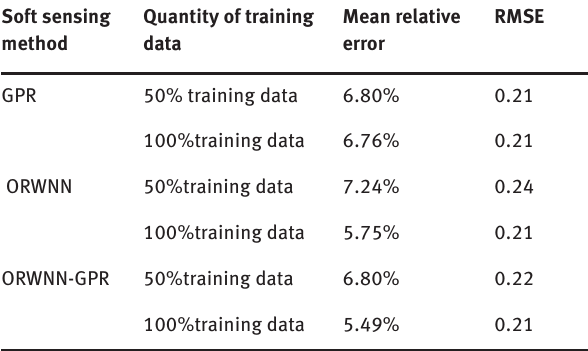
Table 2: Prediction and analysis of ORWNN-GPR model and two other ORWNN and GPR